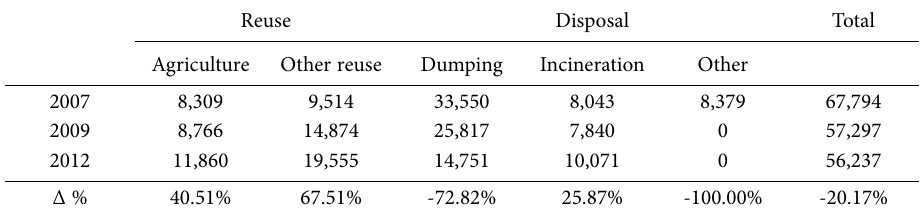
Table 5. Quantity of reused and disposed muds per typology in the Emilia-Romagna region. Reuse Disposal Total Agriculture Other reuse